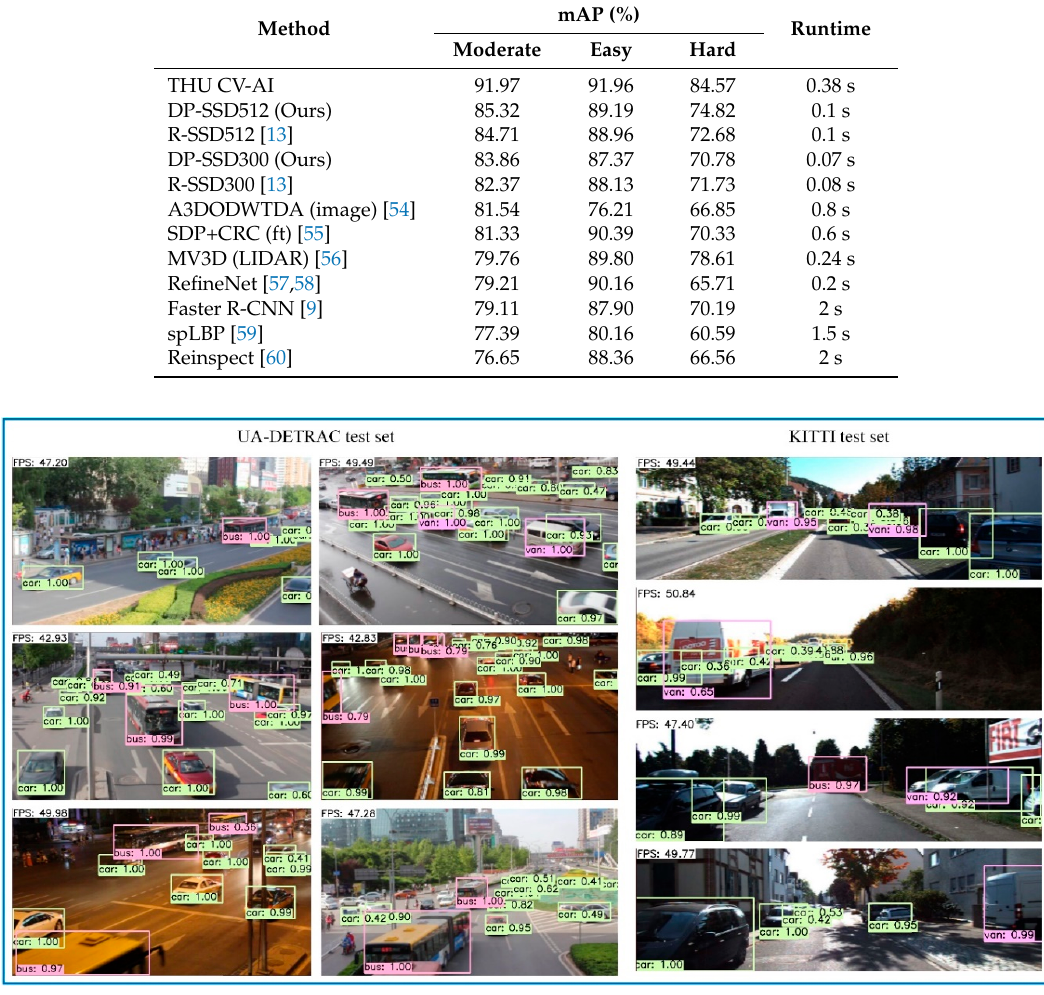
Figure 7. Selected examples of vehicle detection results on UA ‐ DETRAC test set and KITTI test set using our proposed DP ‐ SSD300 framework. Both UA ‐ DETRAC and KITTI test sets are made into video sequence for testing. We display high quality detections with scores higher than 0.3. The detected frame rate is displayed in the upper left corner, and each output box is associated with a category label and a specific score.